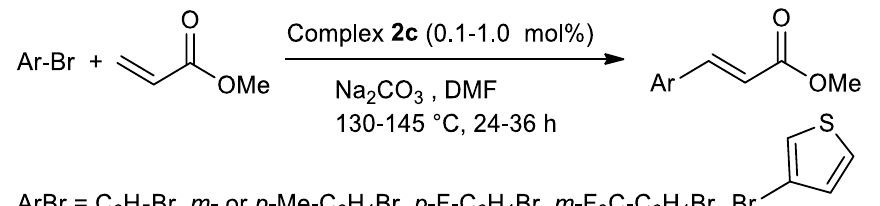
Scheme 4. Heck reaction of aryl bromides with styrene catalysed by complex 1a : The first reported use of a thiosemicarbazone in the Heck reaction.